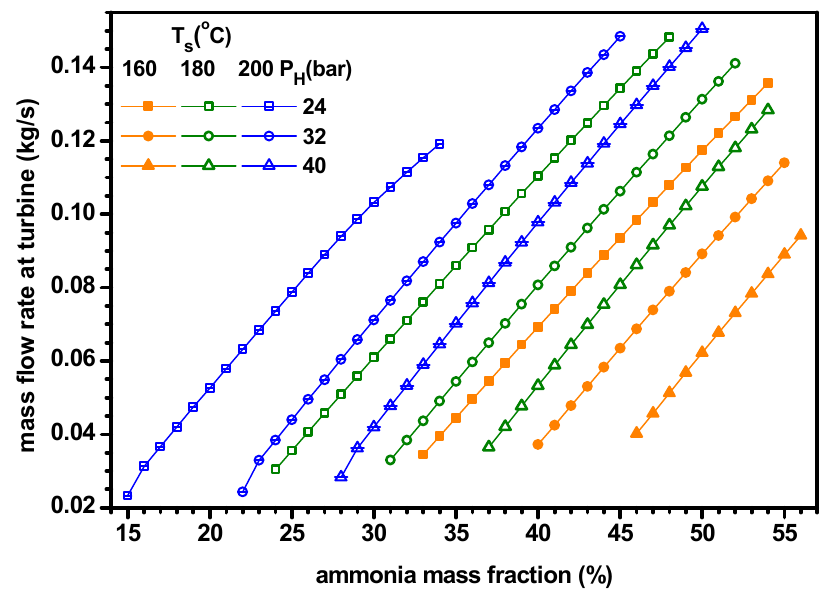
Figure 8. Mass flow rate at turbine for varying ammonia fraction.